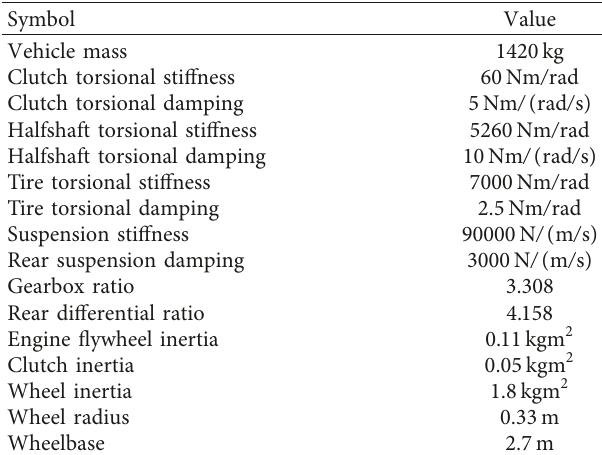
Table 4: Main parameters of the